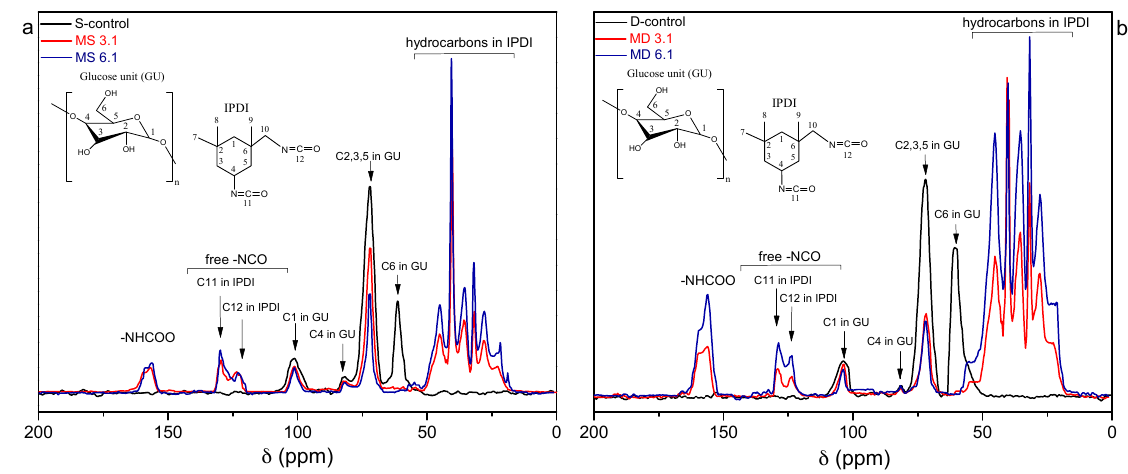
Figure 2. 13 C nuclear magnetic resonance ( 13 C NMR) spectra of S-control, MS 3.1 and MS 6.1 ( a ) and D-control, MD 3.1 and MD 6.1 ( b ).